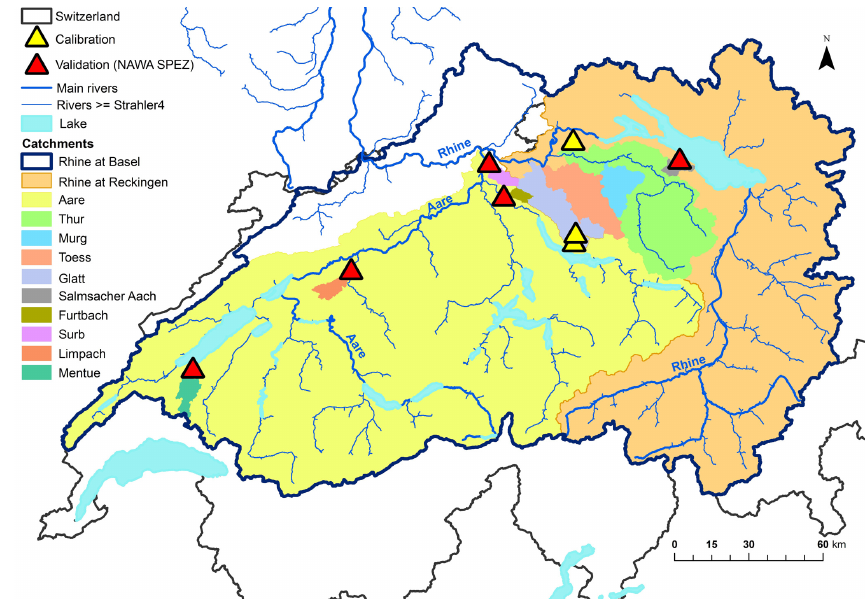
Figure 2. Calibration and validation catchments in Switzerland. Base data: Vogt et al. (2007); Swisstopo